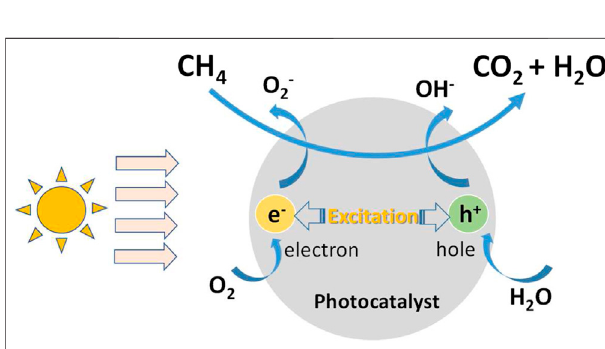
FIGURE 2 | The mechanism diagram of photocatalytic oxidation of methane.